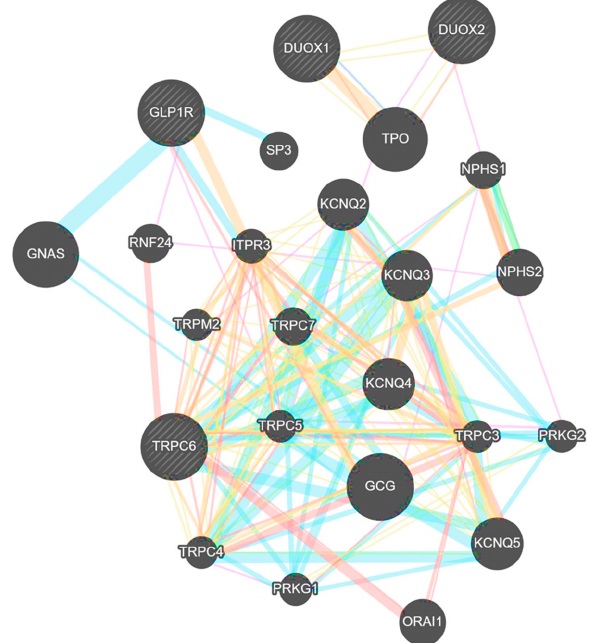
Figure 5. Protein interactions between TRPC6, DUOX1, DUOX2, GLP1-R, nephrin, podocin and other proteins in humans obtained from GeneMANIA database. Colors of the matching lines in the figure indicate different types of interactions: orange line indicates predicted interaction, blue line indicates shared pathway, green indicates genetic interactions, yellow indicates shared protein domains, pink indicates physical interactions, blue indicates co-localization and purple indicates co-expression. The width of the line reflects the significance of interaction: the thicker the line, the more robust the prediction of the interaction. TRPC: transient receptor potential channel, NPHS2: podocin, NPHS1: nephrin, RNF24: RING finger protein 24, KIRREL: Kin of IRRE-like protein 1, PLCG1: 1-phosphatidylinositol 4,5-bisphosphate phosphodiesterase gamma-1.